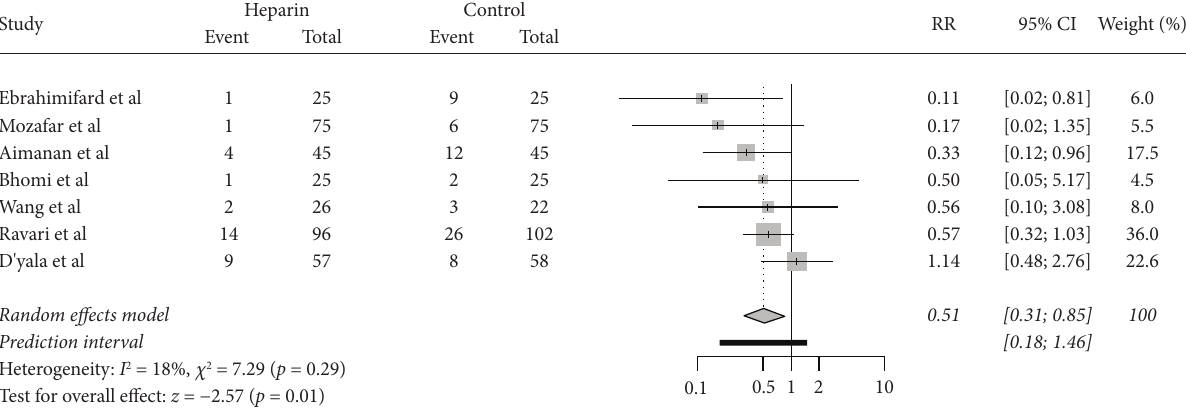
Table 1. Four trials used 5000 IU for case patients; one trial used 75 IU/kg, one used 80 IU/kg, and one used 100 IU/kg.